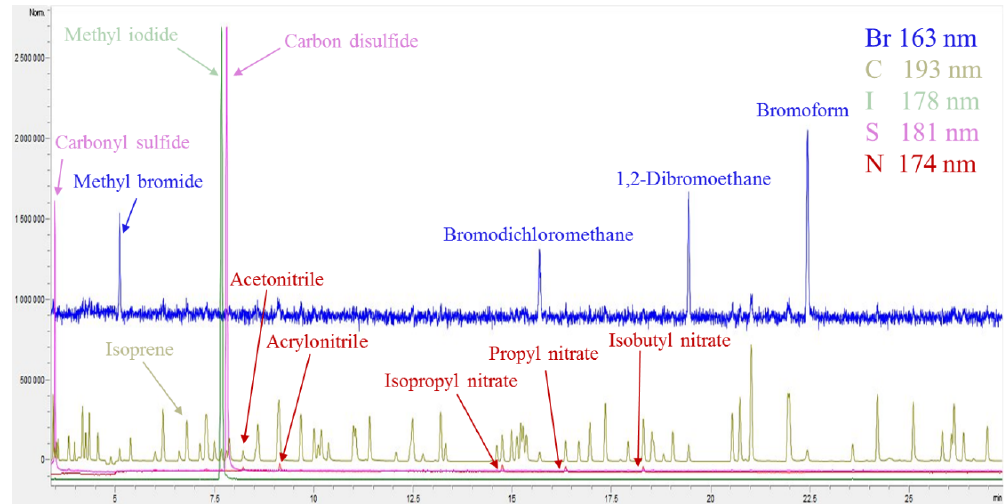
Figure 2. Example CryoTrap–GC–AED normalized multi-element overlay chromatogram of the ∼ 250pptv 84-component Apel-Riemer- 2015 gas calibration